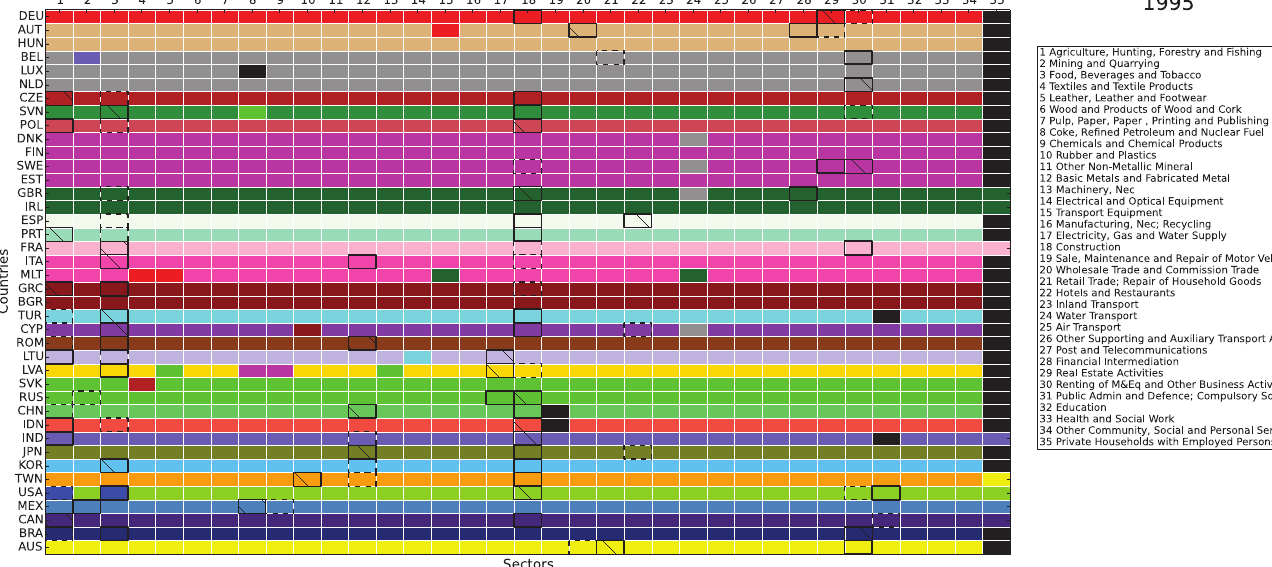
Fig 8. Community detection and community core detection results in 1995. The economies are arranged by rows and the industries are arranged by columns. Each color represents a community detected, except that the black color indicates the isolated nodes with only self-loop. Within each community, the top 3 core economy-industry pairs are identified. The first place is with thick and solid border. The second place is with thick and dashed border. The third place is with border and